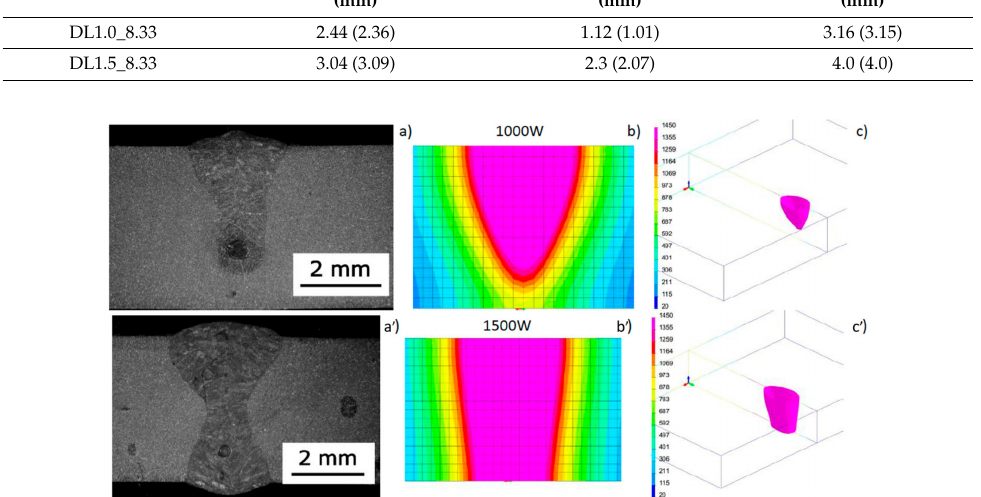
Figure 7. View of the macrostructure of the bead ( a , a’ ) in bead-on-plate welding tests performed on a 4.0-mm-thick sample of AISI304 steel using the Trumpf TruDisk 3302 disk laser at laser beam power accordingly 1000 and 1500 W and welding speed of 8.3 mm / s; ( b , b’ ) a cross-sectional view of the molten pool obtained as a result of numerical simulation; ( c , c’ ) the 1450 ◦ C